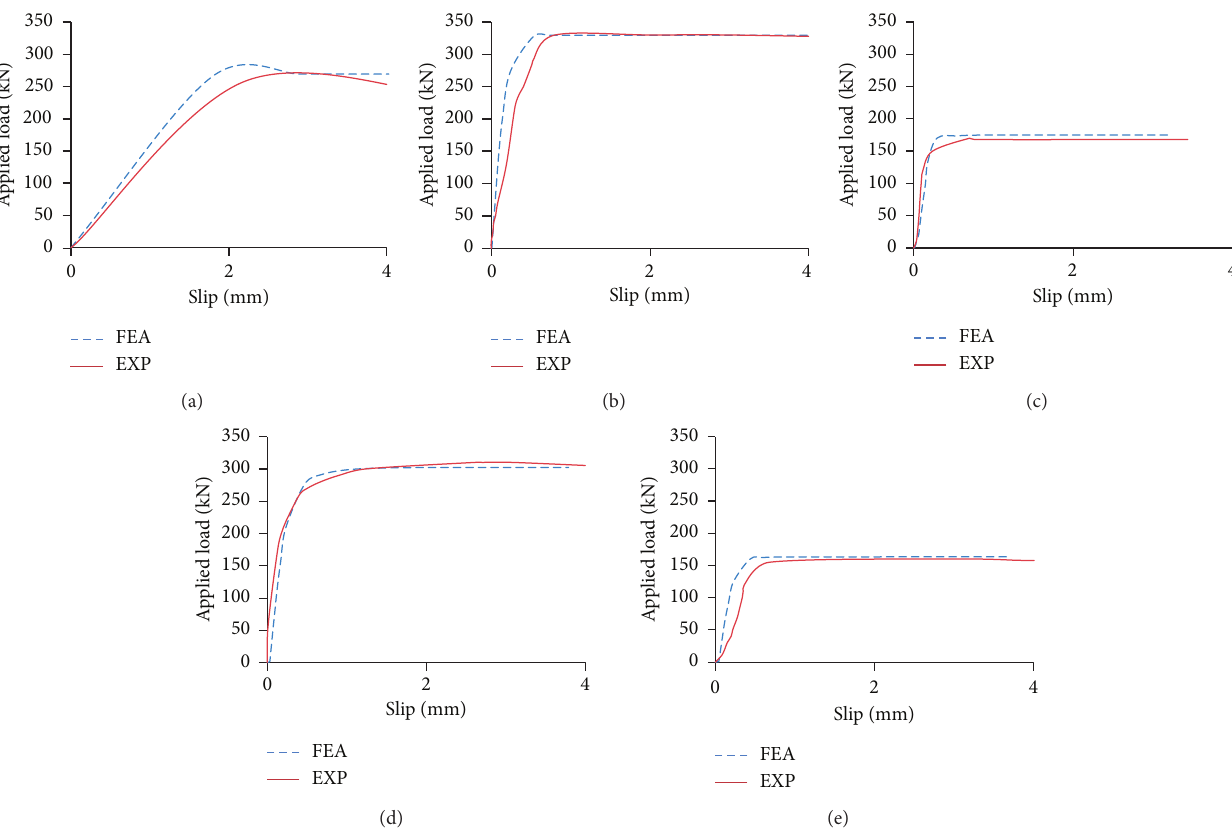
Figure 7: Applied load vs slip behavior: (a) CFST; (b) SCCFC-4-O; (c) SCCFC-4-I; (d) SCCFC-3-O; (e)